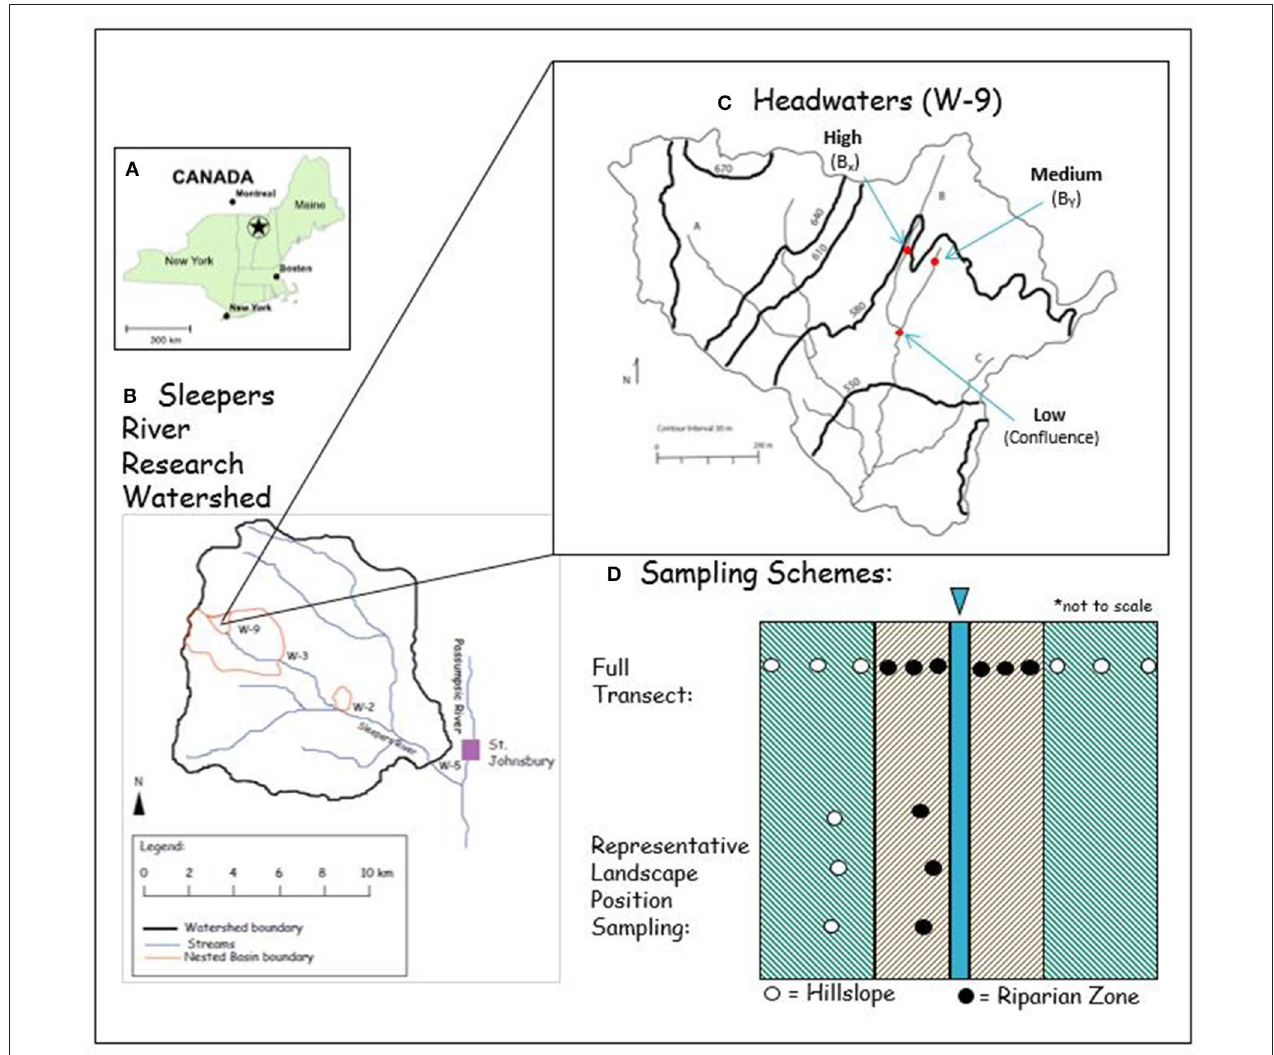
FIGURE 1 | (A) The location of the study site in the NE US. (B) The Sleepers River Research Watershed is located west of St. Johnsbury, VT (modified after Shanley et al., 2015 with permission from John Wiley and Sons). (C) The headwaters (W − 9) with stream B is the focus of this study (modified after Kendall et al., 1999 with permission from Elsevier). (D) Schematic representation of the sampling design in map view (not to scale) that included samples from full transects from HSs (green shaded area) and RZs (brown shaded areas) to the stream (blue). Representative zone samples included replicated samples for each landscape position (each dot represents 3